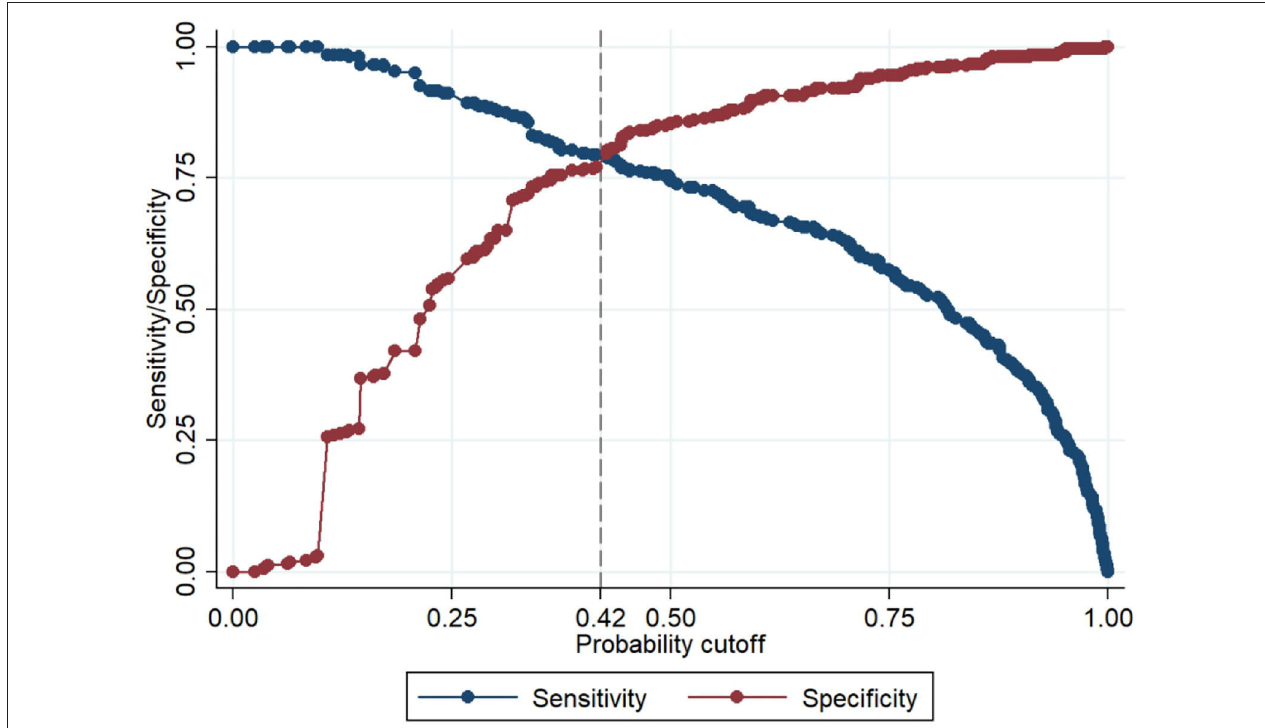
FIGURE 1 | The sensitivity and specificity of our electrocardiogram (ECG) model intersected at the point 0.42, which means acute pulmonary embolism (acPE) should be considered when the probability is ≥ 0.42 and the corresponding score is − 0.3228.